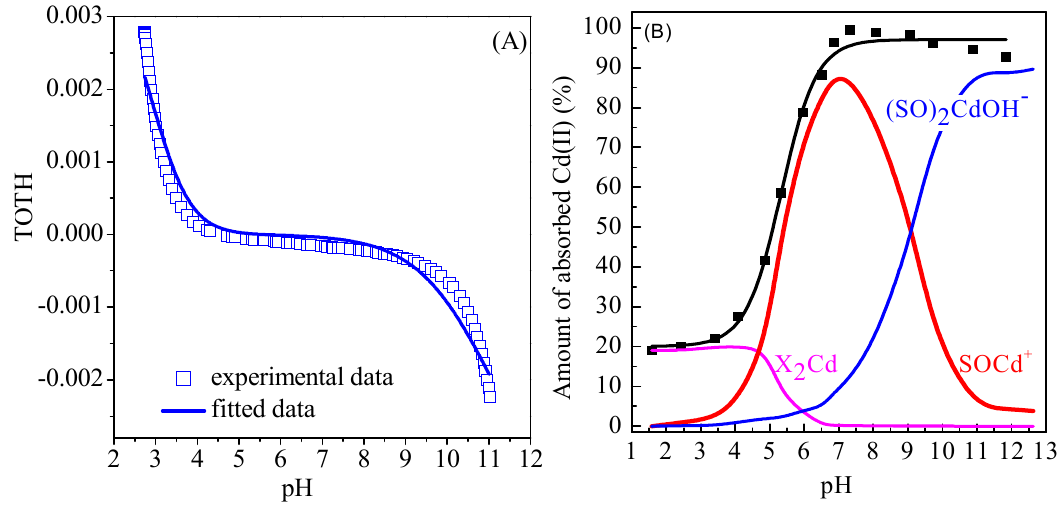
Figure 5. ( A ) Fitting of potentiometric data of Cd(II) on Mn oxide in the presence of 0.01 mol/L NaClO 4 ; ( B ) Surface complexation modeling of Cd(II) on Mn oxide ( C = 10 mg/L, I = 0.01 mol/L NaClO 4 , m/v = 1 g/L, T = 298 K).